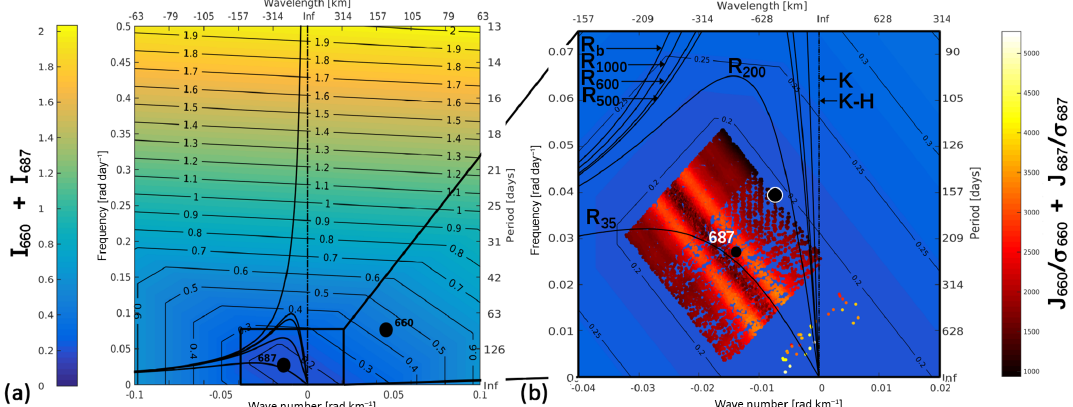
Figure 6. Difference between observed Lagrangian float wave characteristics and Lagrangian theoretical wave ones (index I , left color bar) for (a) the sum of floats 660 and 687 and (b) the associated minimum calculations (normalized index J , right color bar) with regard to dispersion equations of Rossby wave (solid line), Kelvin wave (dotted line) and Kelvin–Helmholtz instability wave (break line). Subscript “b” denotes a barotropic case; subscripts with a number denote a baroclinic case with stratification at the depth of this number. A negative wavelength describes a westward wave. Black dots indicate the observed Lagrangian parameters, of which in (b) only 687 are inside the range; the red dots show the minima of the index and hence the best parameters that can explain both trajectories; the black dot encircled in white is the couple ( ω TMe , k TMe ) that best fits the 660 and 687 float